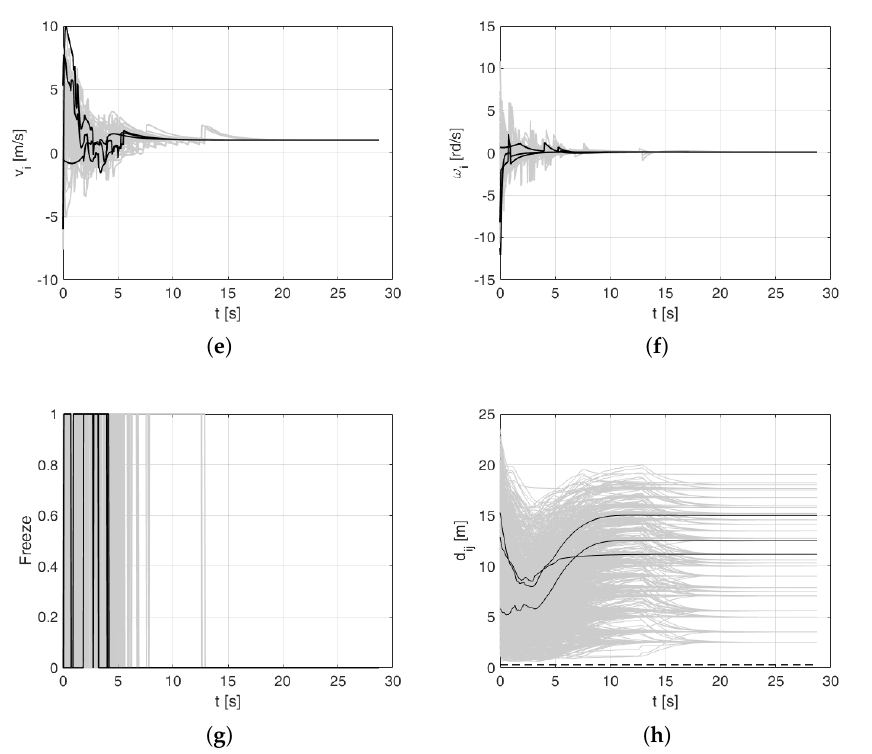
Figure 12. Numerical simulation 2: trajectory tracking for N = 48 robots with goal exchange. ( a ) locations of robots in xy -plane, ( b ) x coordinates as a function of time, ( c ) y coordinates as a function of time, ( d ) robot orientations as a function of time, ( e ) linear velocity controls, ( f ) angular velocity controls, ( g ) ‘freeze’ signals, ( h ) distances between